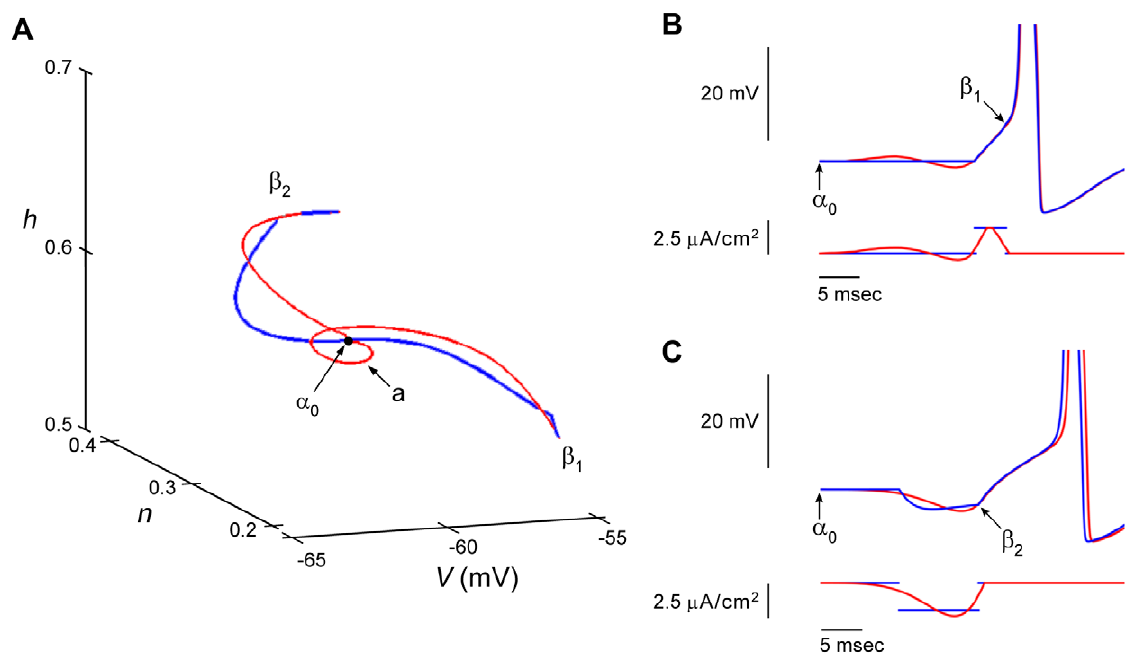
Figure 2. Two distinct mechanisms of neuronal excitation in the Hodgkin & Huxley model. A ) Three dimensional phase representation of state variables ( h , sodium channel inactivation; n , potassium channel activation; V , membrane potential). Depolarizing stimulation currents induce a state change from rest a 0 to threshold b 1 and post-inhibitory rebound stimulation induces excitation via state change from rest a 0 to threshold b 2 . Blue trajectories are paths corresponding to rectangular current pulses; red trajectories are the optimized paths computed from the model with the calculus of variations. Note the small loop ( a ) of the optimized depolarizing trajectory. B ) and C ) illustrate the two mechanisms of excitation using the same depolarizing and post-inhibitory rebound stimulations shown in A ). Membrane potential changes elicited by rectangular pulses are shown in blue; changes elicited by the stimuli calculated from the calculus of variations are shown in red. Further details given in the text.